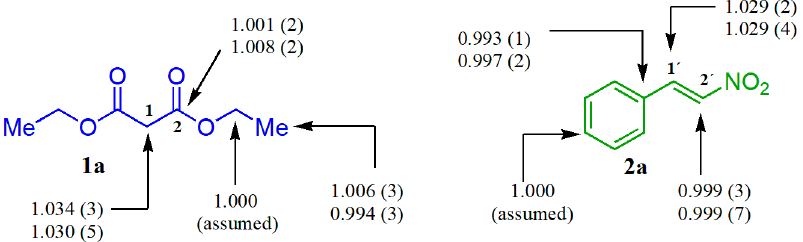
Figure 5. Experimentally measured KIEs for the enantioselective Michael addition of diethyl malonate to trans- β -nitrostyrene catalyzed by C1 [25].